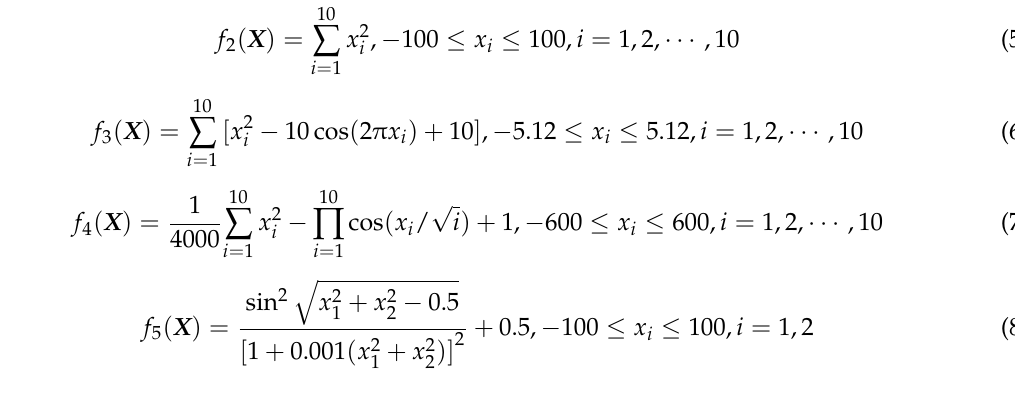
Table 1. Comparison of test